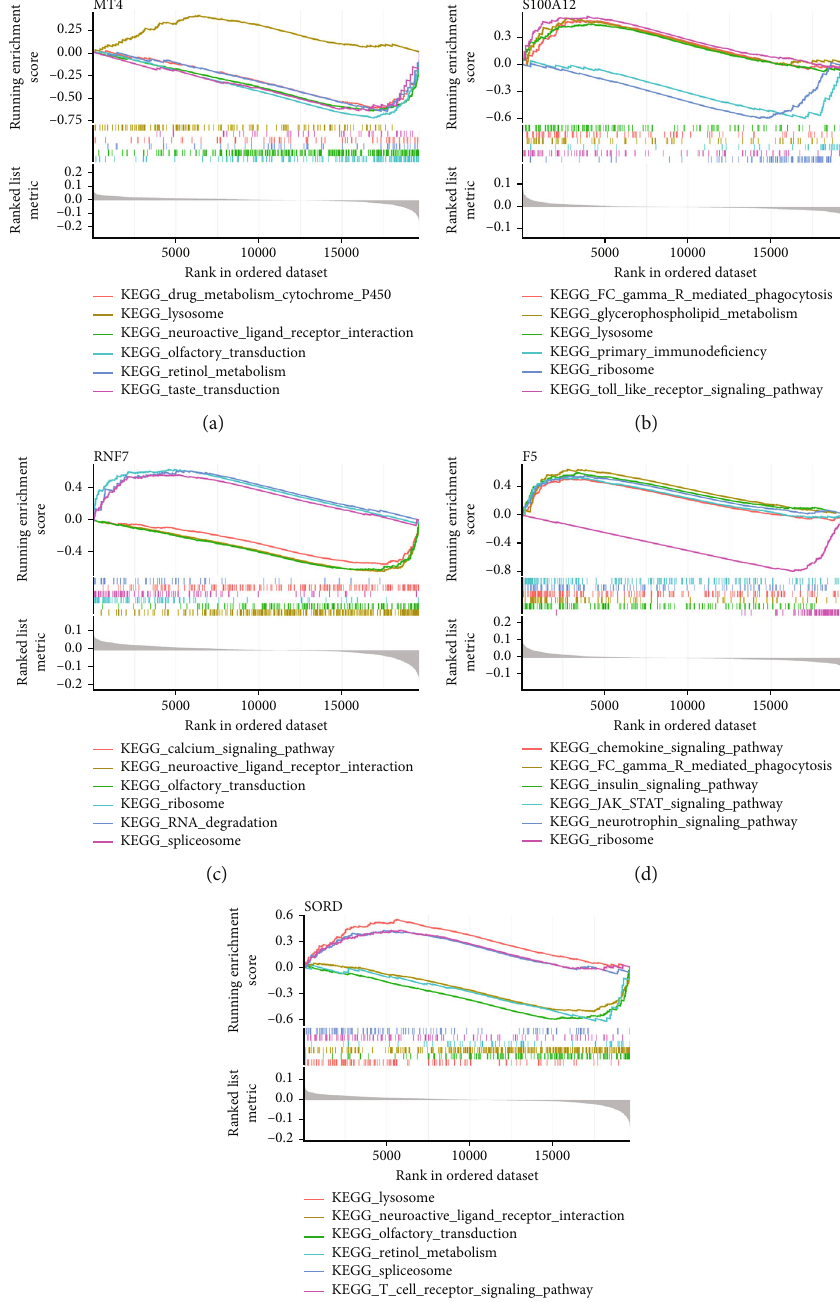
Figure 4: Marker genes of CAD were correlated with immune regulation. (a) GSEA of marker gene MT4. (b) GSEA of marker gene S100A12. (c) GSEA of marker gene RNF7. (d) GSEA of marker gene F5. (e) GSEA of marker gene